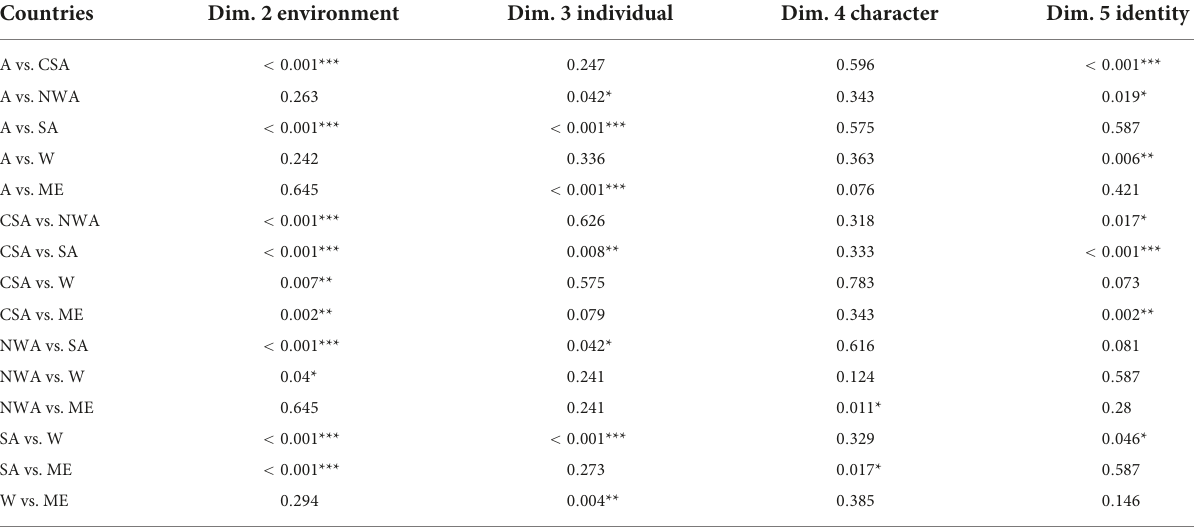
TABLE 2 Adjusted p of pairwise cultural similar countries (CSC) comparisons for dimensions 2–5 (* p < 0.05; ** p < 0.01; and *** p < 0.001). Countries Dim. 2 environment Dim. 3 individual Dim. 4 character Dim. 5